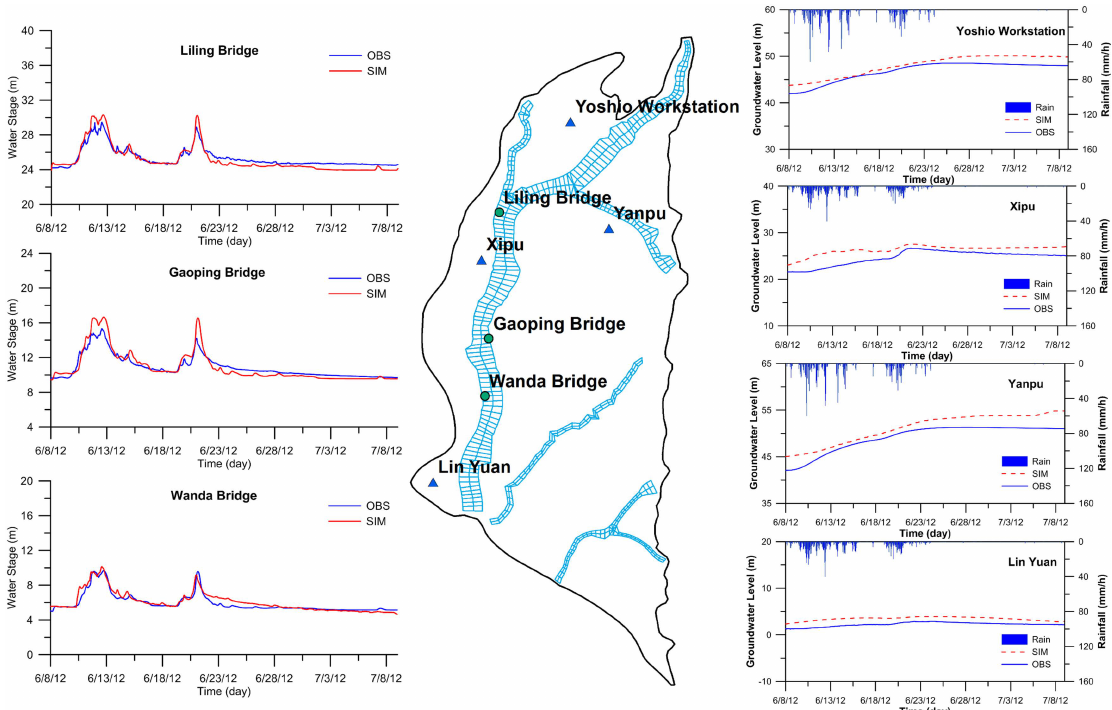
Figure 9. Validation results of river stages in the Gaoping River ( left ) and groundwater levels ( right ) from 8 June–8 July of 2012 when Tropical Storm Talim affected